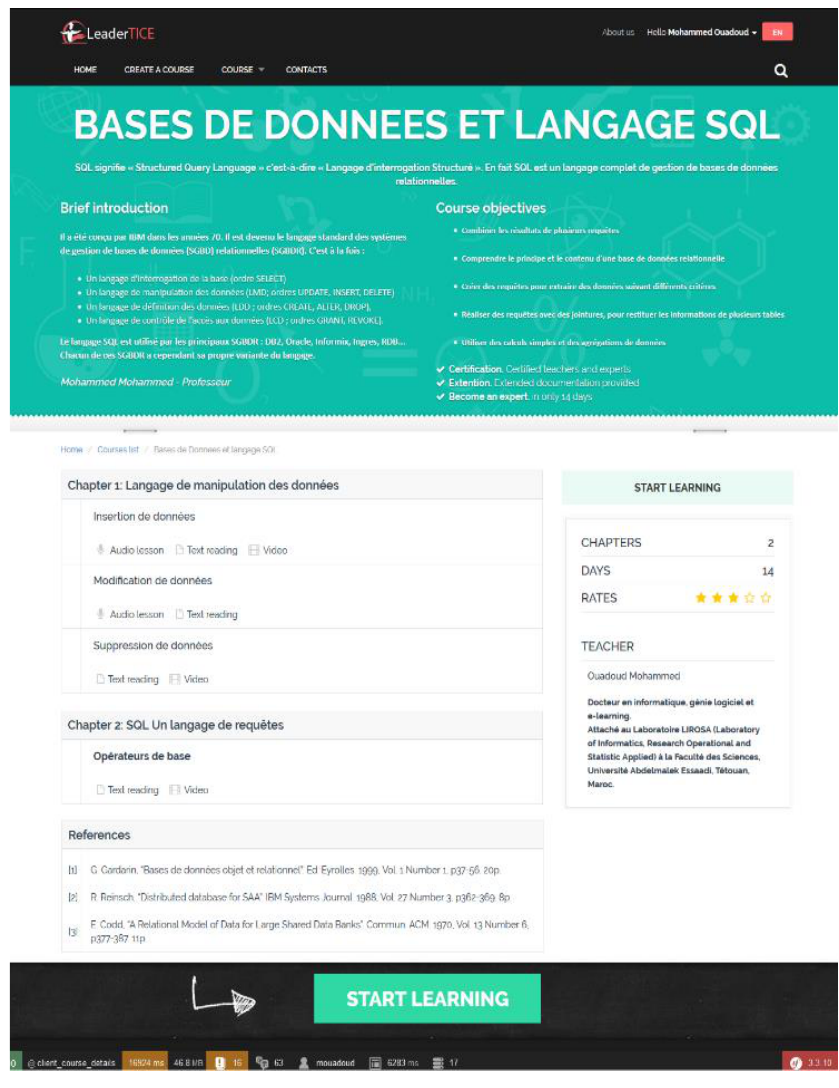
Fig. 9. General plan of a course developed via Sumfony